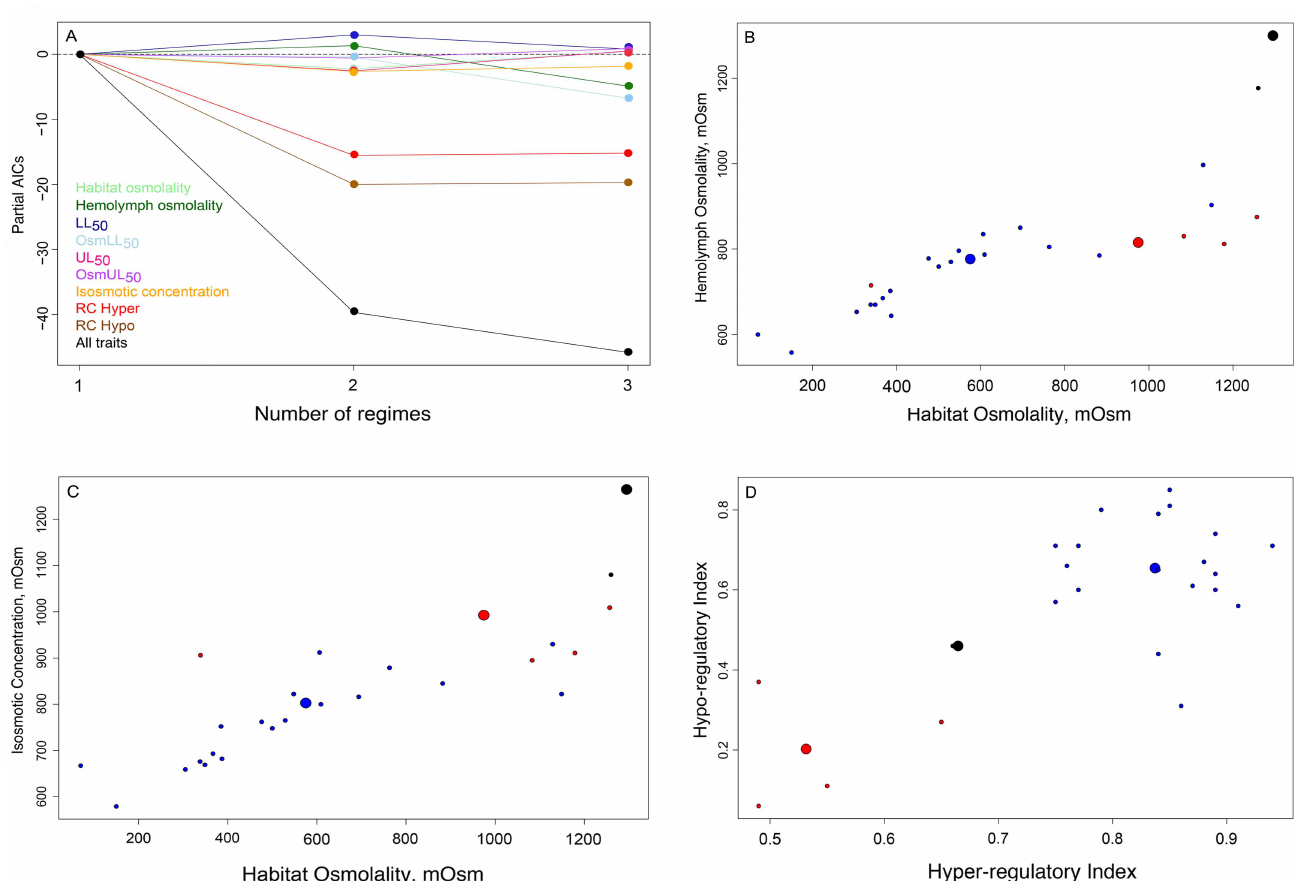
Fig 7. Results of a SURFACE analysis using osmoregulatory traits in 24 Uca species. A, Relativecontribution of osmoregulatory traits in Uca to model fitting, showingthe Partial AIC scores for each (coloredlines), and for all traits together (multidimensional) (black line). Hyper- (RC hyper ) and hypo- (RC hypo ) osmoregulatory indices contributed strongly to model fitting by reducingthe AIC values. Hemolymph osmolality, osmolalityat LL 50 , and isosmotic concentration contributed moderatelyto the model; all other osmoregulatory traits reducedmodel fitting. B, C and D, Estimated positionof the species’traits and adaptivepeaks, consideringonly those traits whose correlationswere tested. Large filled circles represent the three optima. Small filled circles are the trait values for each of the 24 fiddler crab speciesevaluated,coloredaccordingto the adaptive peak to which they belong.